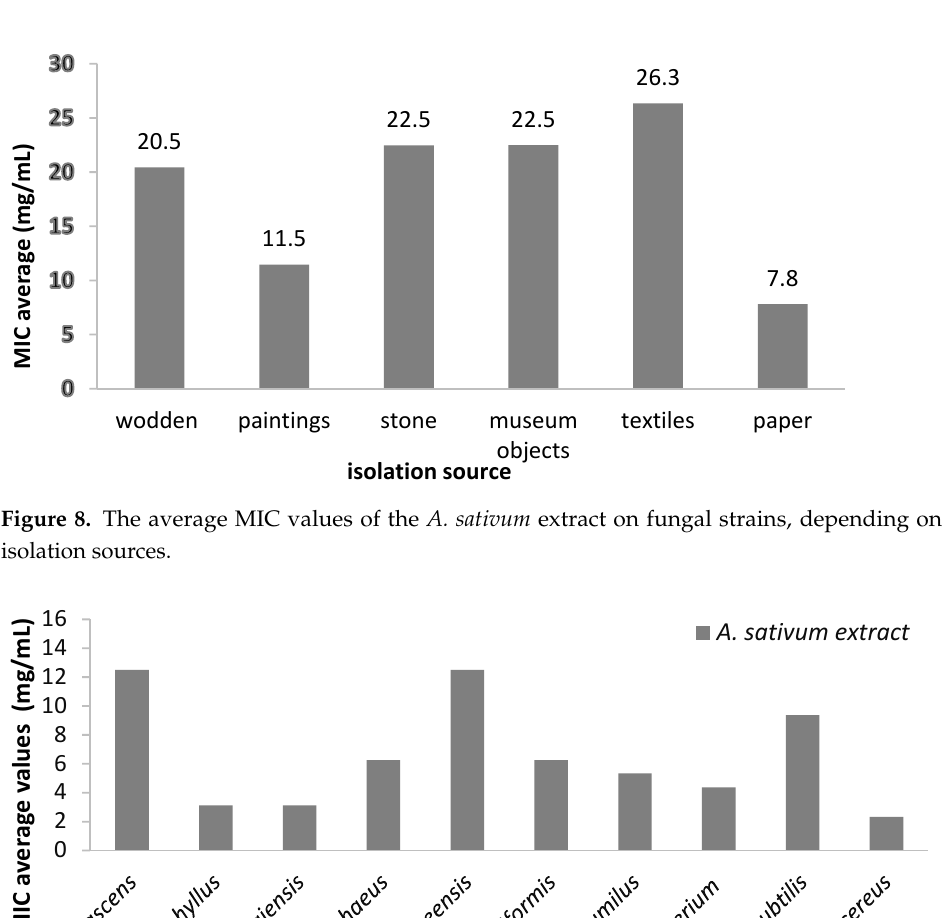
Figure 8. The average MIC values of the A. sativum extract on fungal strains, depending on the iso- lation sources.